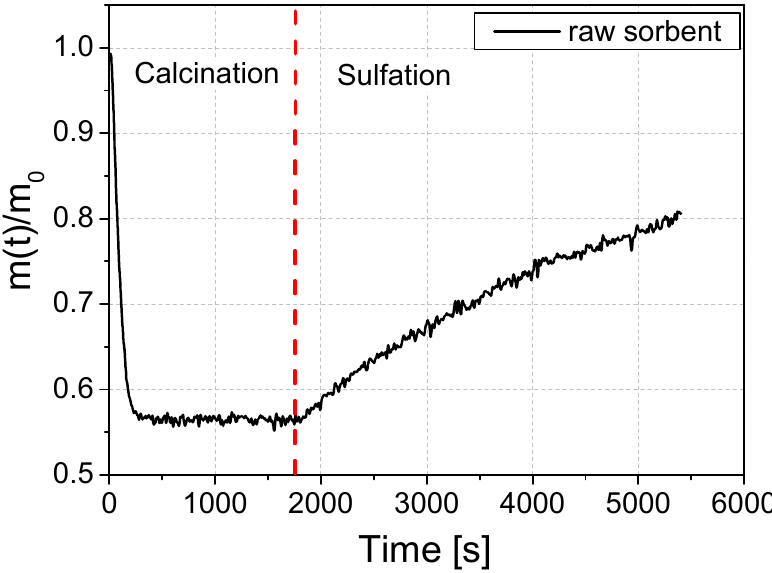
Figure 4. An example of a course of mass change during the reactivity test on the example of a raw sorbent sample.